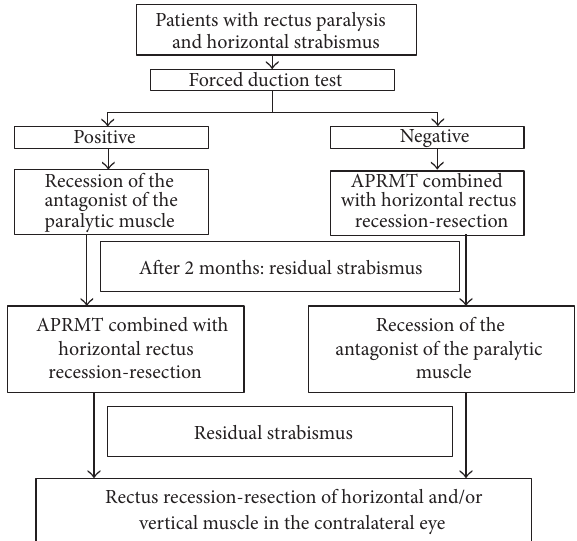
Figure 1: Flowchart of the surgical